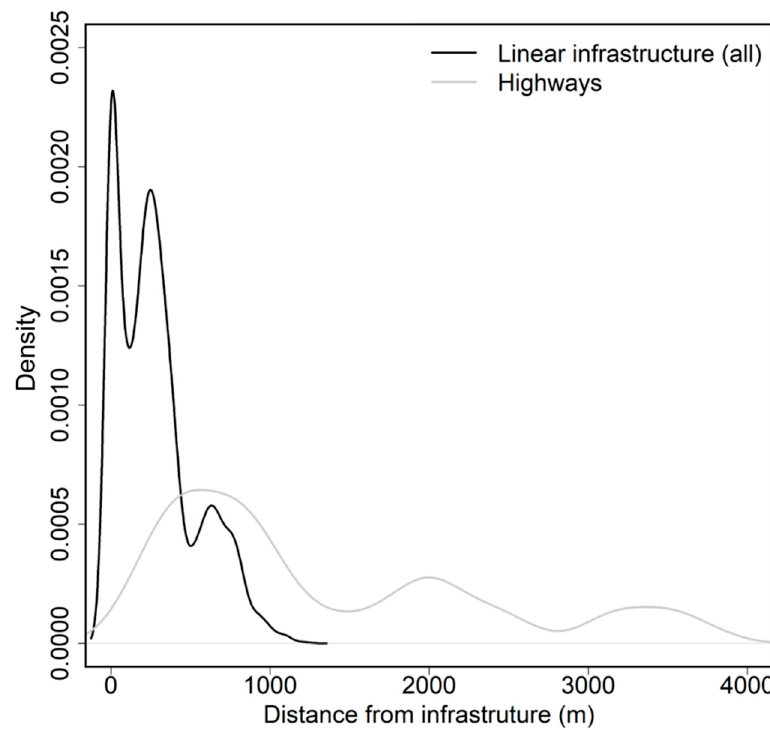
Figure 3. Density of step length of GLT locations at variable distances from linear infrastructure. Table 1. Models that explained the step length of GLT groups. Step = step length; inf = type of linear infrastructure (highway, unpaved road, pipeline, and powerline); land = landscape features (native habitat (forest and regeneration areas), no habitat (pasture and linear infrastructures)); dist_inf = distance to the closest infrastructure; dist_hig = distance to the closest highway.